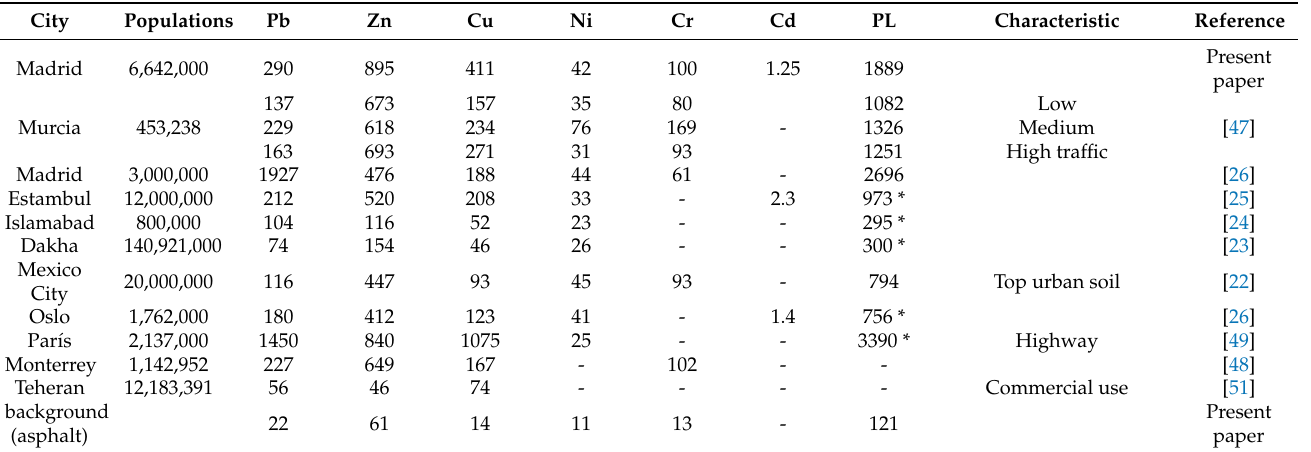
Table 2. A comparison of the heavy metal concentrations (mg kg − 1 ) in street dust in Madrid and other selected cities from the literature